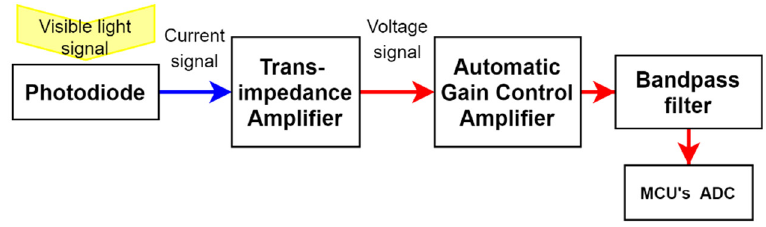
Figure 9. The structure of the receiving system.